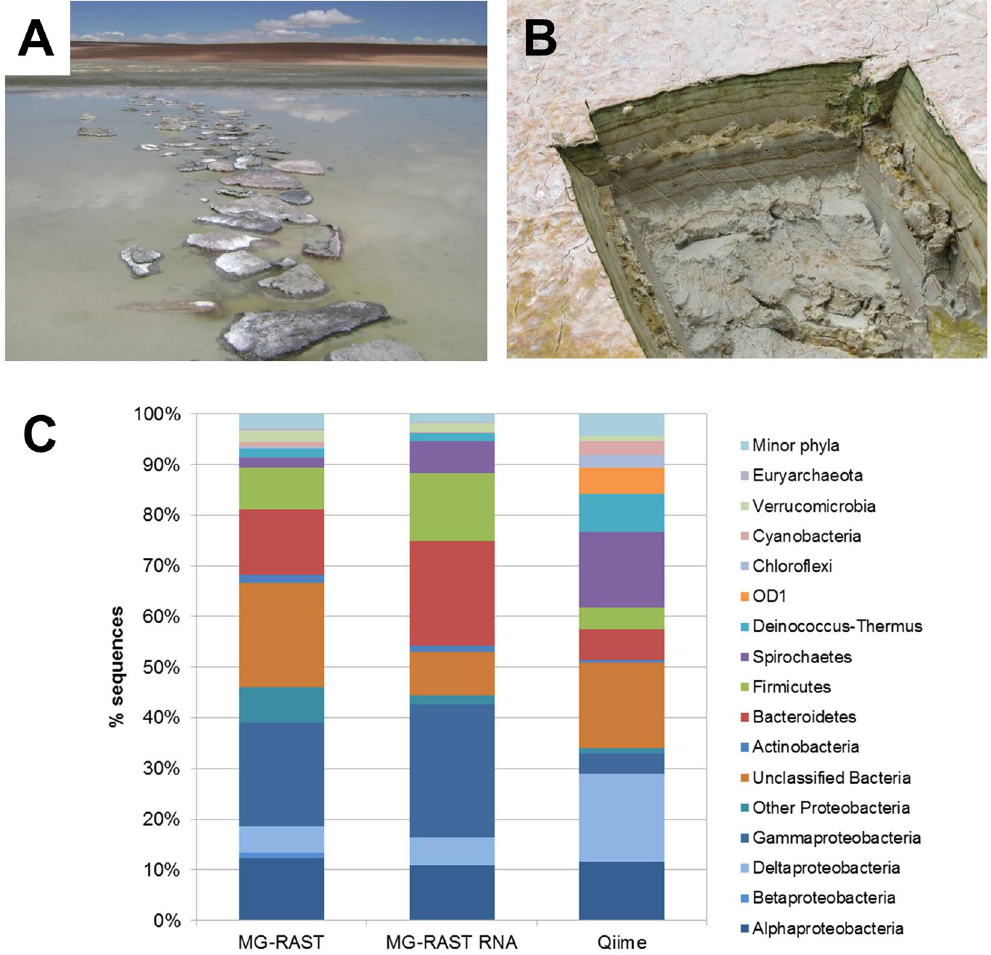
Figure 1. ( A ) Socompa stromatolites. ( B ) Vertical section. ( C ) Taxonomic diversity analysed by different methods: MG-RAST results based on assembled data compared to M5NR database, and MG-RAST assignment of RNA reads, updated Qiime analysis on published 16S rRNA data 19